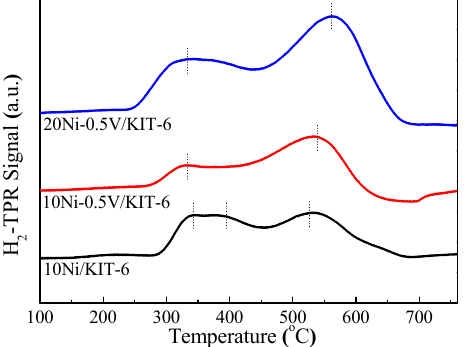
Figure 2. H 2 -TPR profiles of Ni-based catalysts.